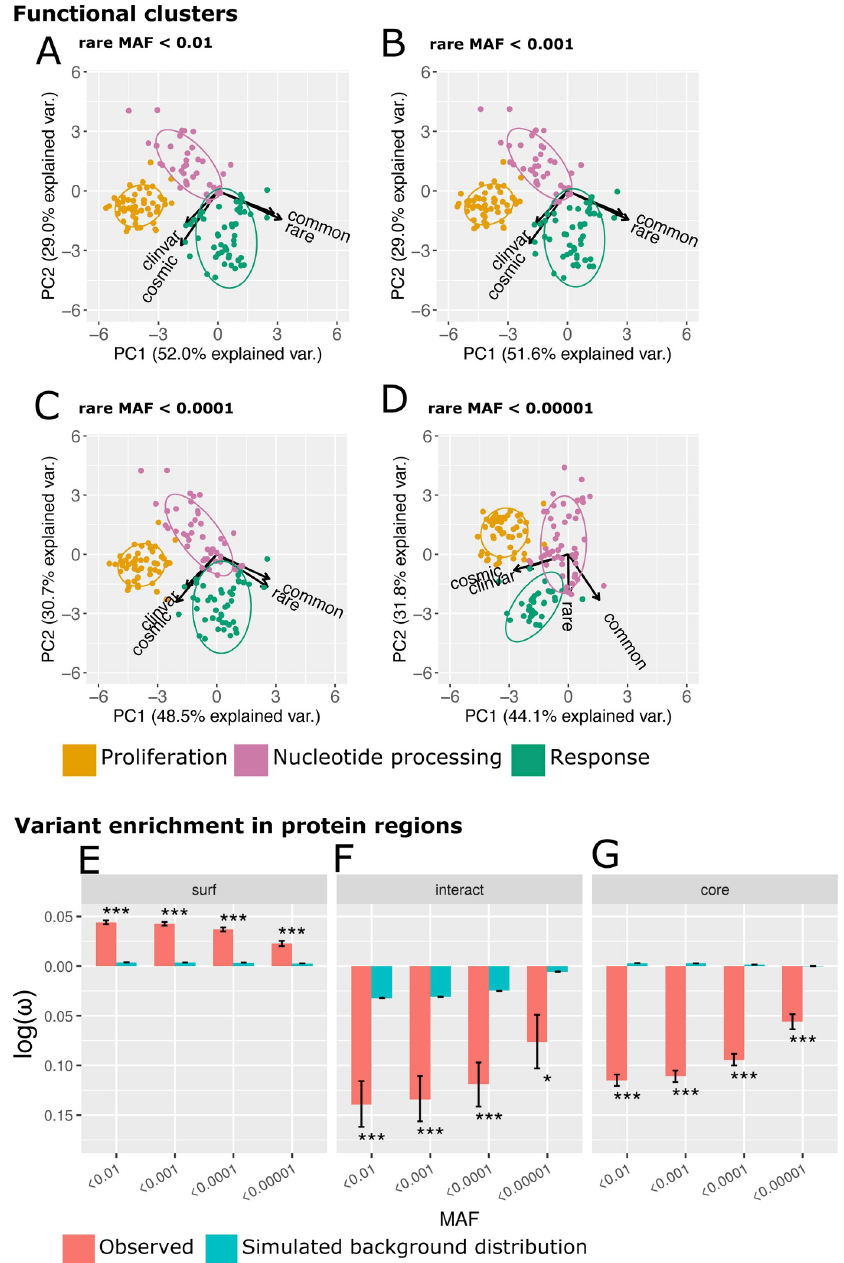
Fig 6. Rare variants are similar to common variants. (A–D) As for Fig 4B, but only the first 2 PCs are depicted, and, in separated panels, increasingly stringent MAFs used to define rare variants. MAF cutoffs of 0.01 (panel A, data identical to Fig 4B), 0.001 (B), 0.0001 (C), and 0.00001 (D) are considered here. See S6 Data for the underlying data. (E–G) The localisation of rare variants to protein surface (E), interface (F), and core (G). Rare variants have been defined using different MAF cutoffs as shown on the x-axes. Here, the density metrics ( ω ) were log-transformed such that negative values indicate a depletion of missense variants, while positive values indicate enrichment. Results for the observed variants (red bars), as well as the background levels based on simulated null distributions (cyan bars), are shown. See S2 Data for the underlying data for the observed statistics. See S12 Data for statistics calculated for individual realisations of the simulated null distribution. MAF, minor allele frequency; PCs, principal components.